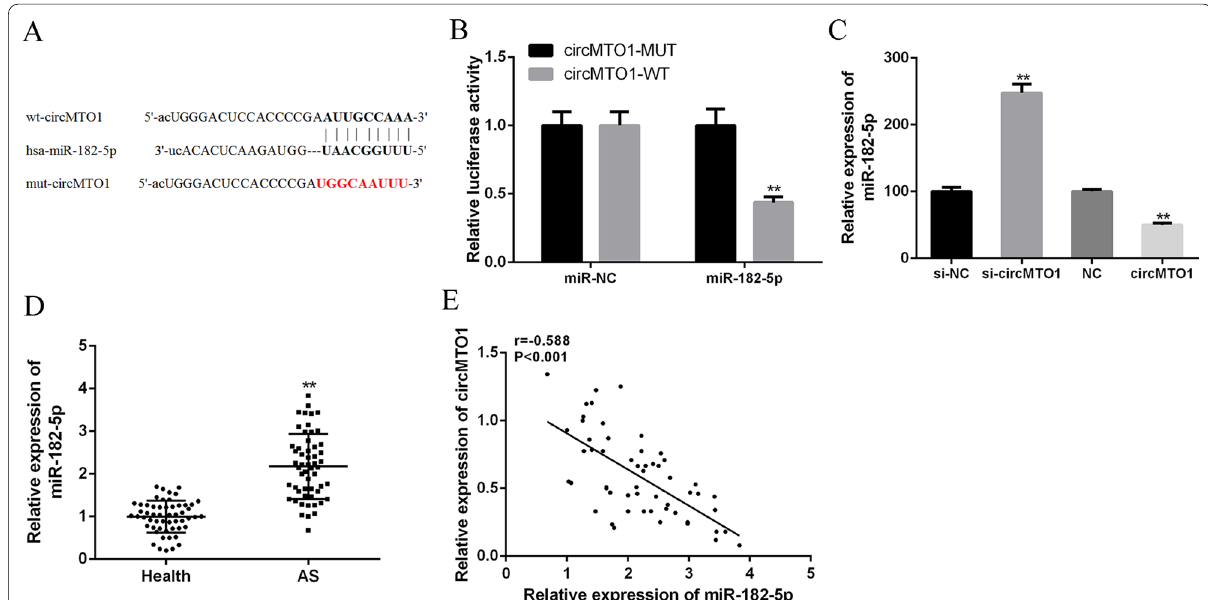
Fig. 3 CircMTO1 acted as a sponge for miR-182-5p in AS. A Starbase predicted putative targeting sites for circMTO1 and miR-182-5p. B Luciferase activity in VSMCs co-transfected with miR-182-5p mimic and pmirg10-circMTO1-WT or pmirg10-circMTO1-Mut vector. C Effect of si-circMTO1 or circMTO1 overexpression plasmid on miR-182-5p expression in VSMCs. D Levels of miR-182-5p expression in serum of AS patients (n healthy volunteers (n 55). E Correlation of circMTO1 and miR-182-5p in serum of AS patients by Pearson analysis (n =